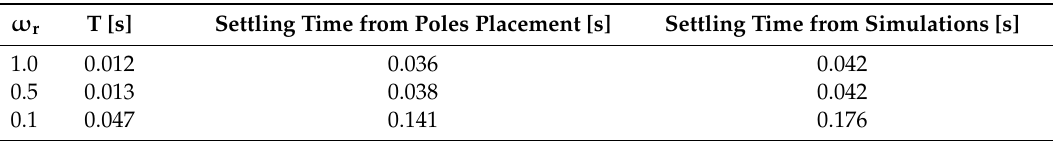
Figure 11. Experimental and simulation studies of the influence of the rotor speed on the poles placement and impulse response of the observer at nominal load torque and rotor flux. Table 1. Comparison of settling time estimated from the placement of the dominant poles with real settling time from